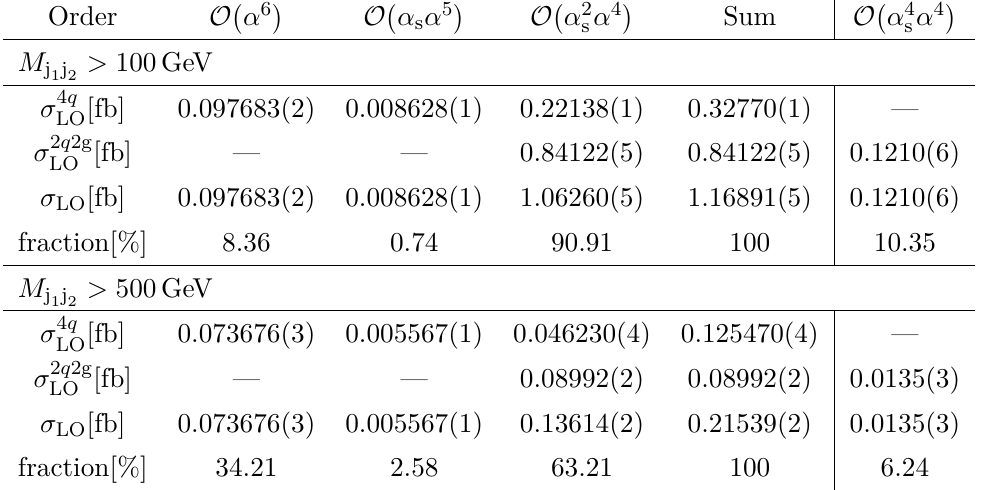
Table 1 . LO cross section of the individual orders O for pp → e + e − µ + µ − jj + X at 13 TeV CM energy. Contributions of partonic channels with four external quarks, σ 4 q , and those with two external quarks and two external gluons, σ 2 q 2 g LO shown separately as well. The loop-induced contribution of O enter the sum of contributions. Each contribution is given in fb and as fraction relative to the sum of the three contributions (in per cent). While the numbers in the upper part of the table are for the inclusive setup, those in the lower part are for the VBS setup. The digits in parentheses indicate integration